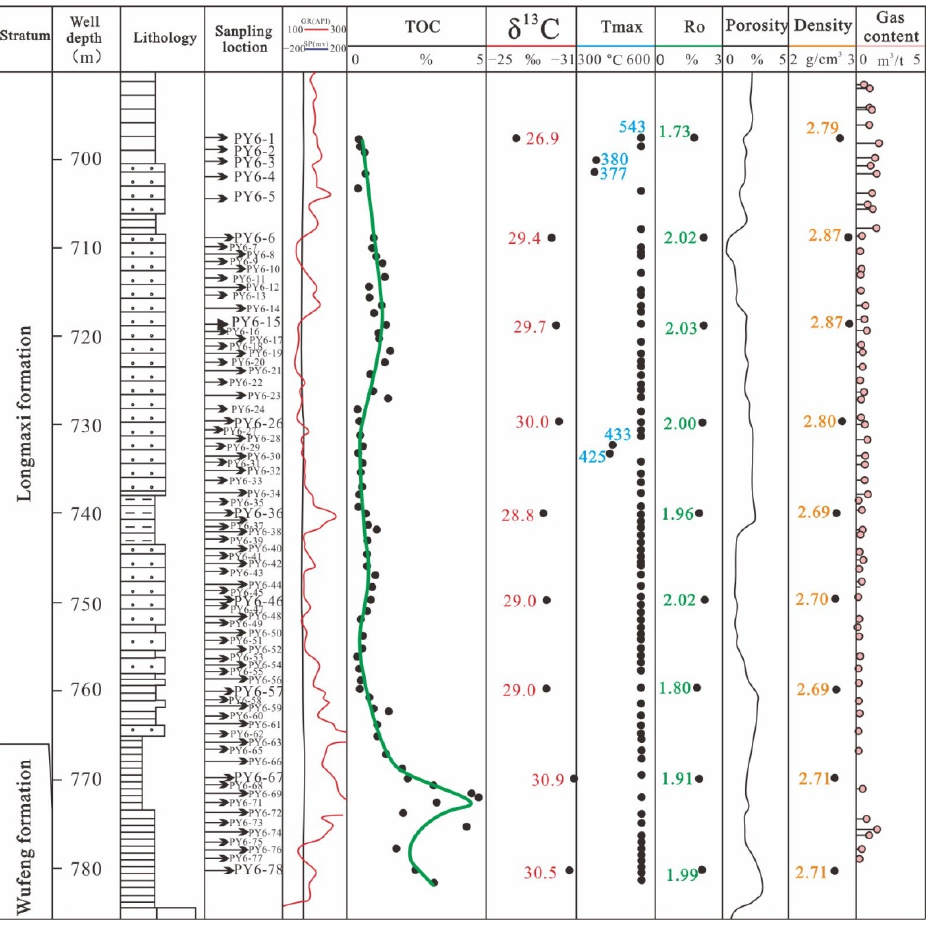
Figure 2. Geochemical parameters at different depths in Well Yucan-6.